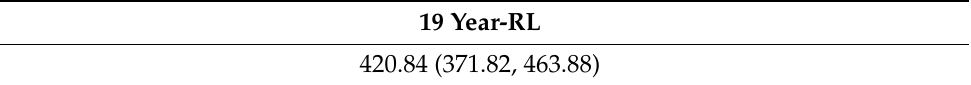
Table 2. Estimate and its 95% CI of the 19 year-RL with bootstrapping in GEV distribution.